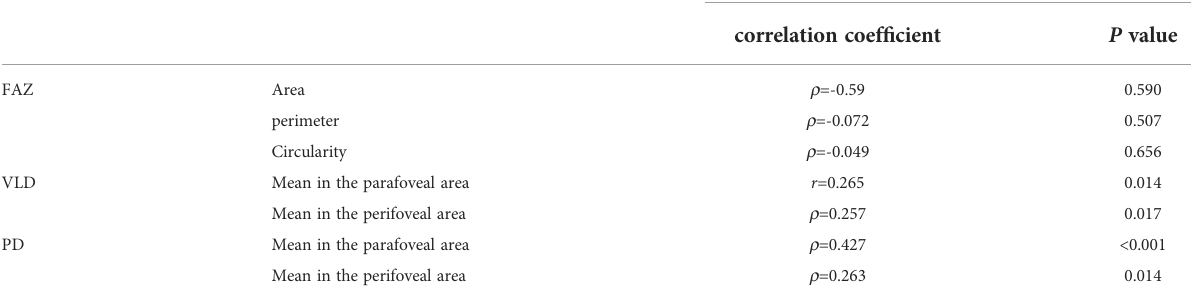
TABLE 3 Correlation between blood perfusion parameters and the mean GCIPL thickness in the macular area of affected eyes in the NDR group. Blood fl ow perfusion parameters in the macular area Mean GCIPL thickness in the macular area correlation coef fi cient P value